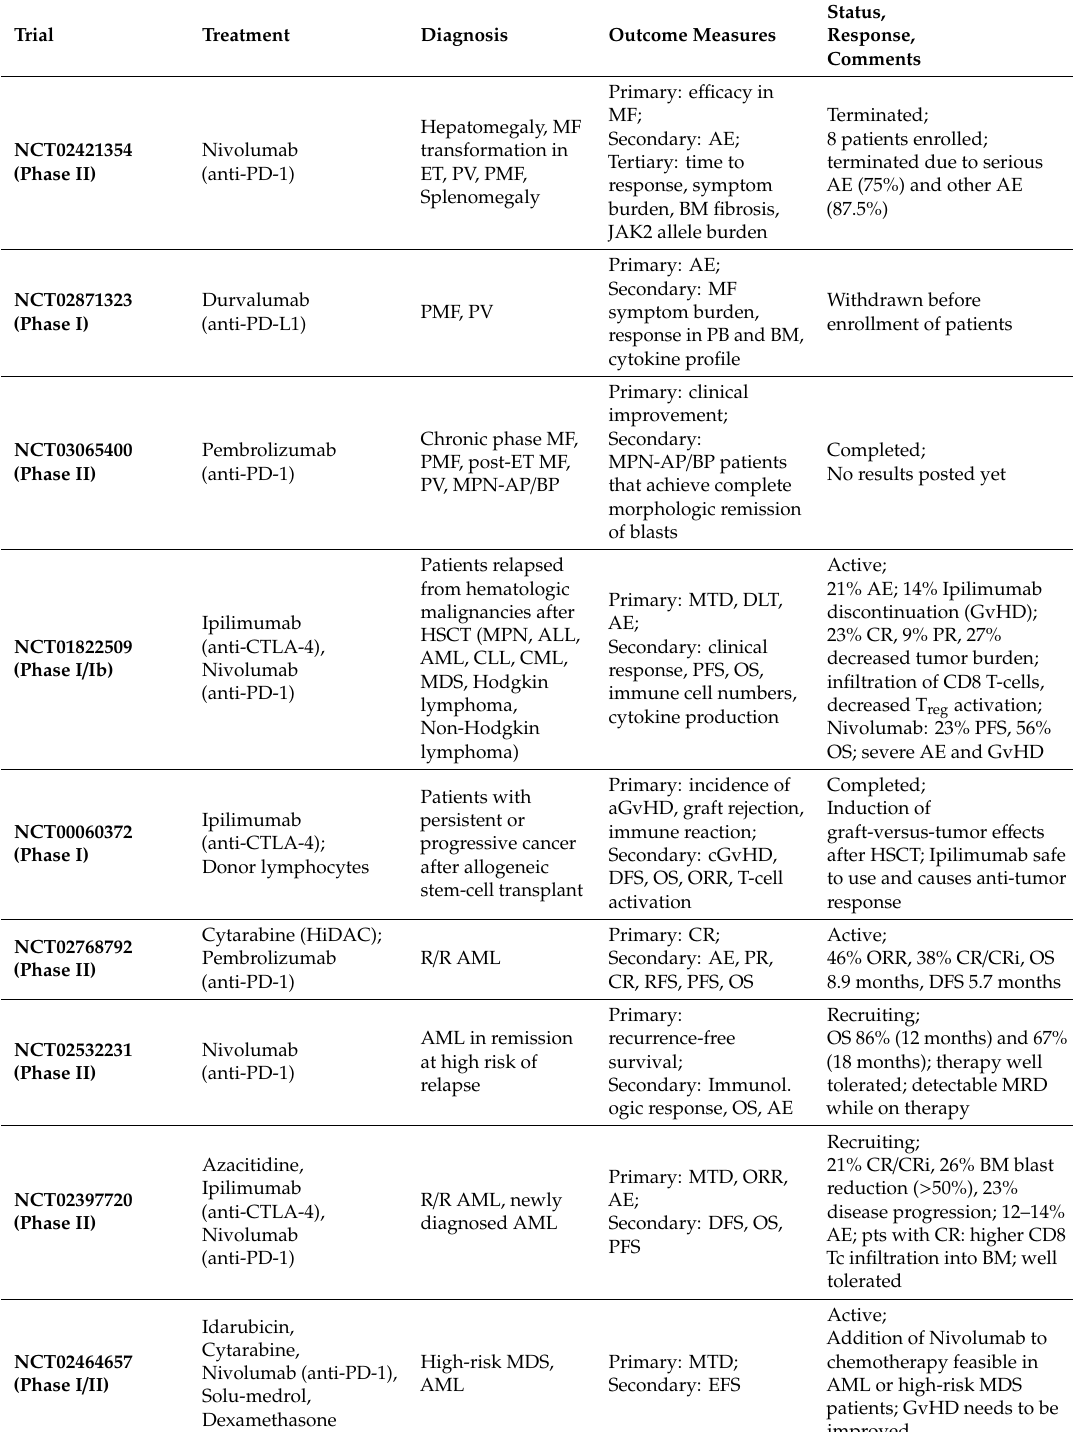
Table 4. Selected Clinical Trials on ICB in myeloid